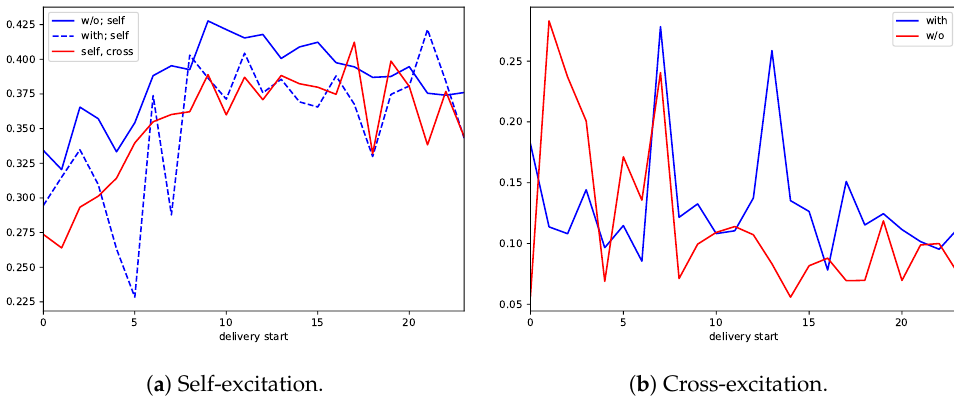
Figure 5. Median branching ratios conditional on the hour of delivery